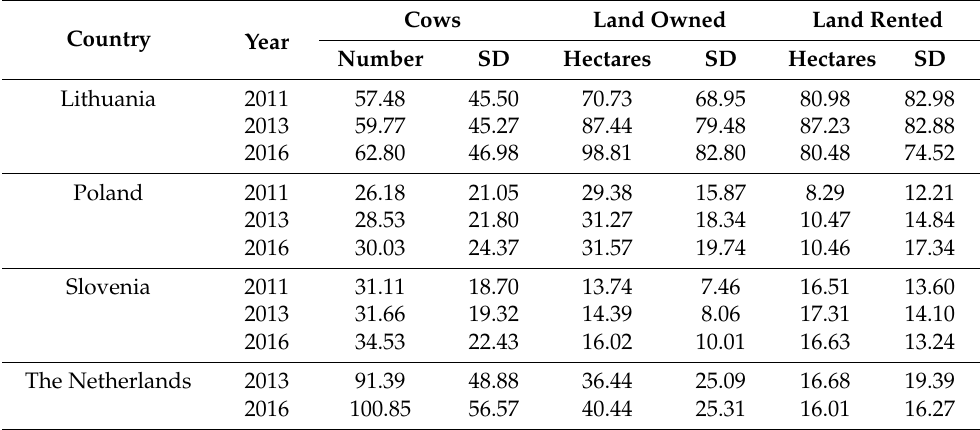
Table 1. Characteristics of the samples of dairy farms in four European countries studied over the period 2011 to 2016—mean value and standard deviation